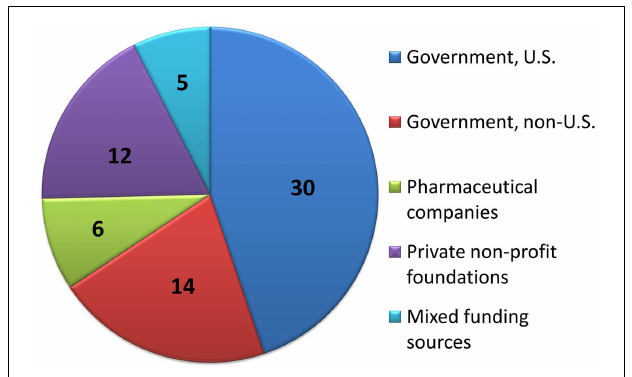
FIGURE 5 | Distribution of primary funding sources . For clinical trials with funding source information provided, the number of studies primarily funded by each source is